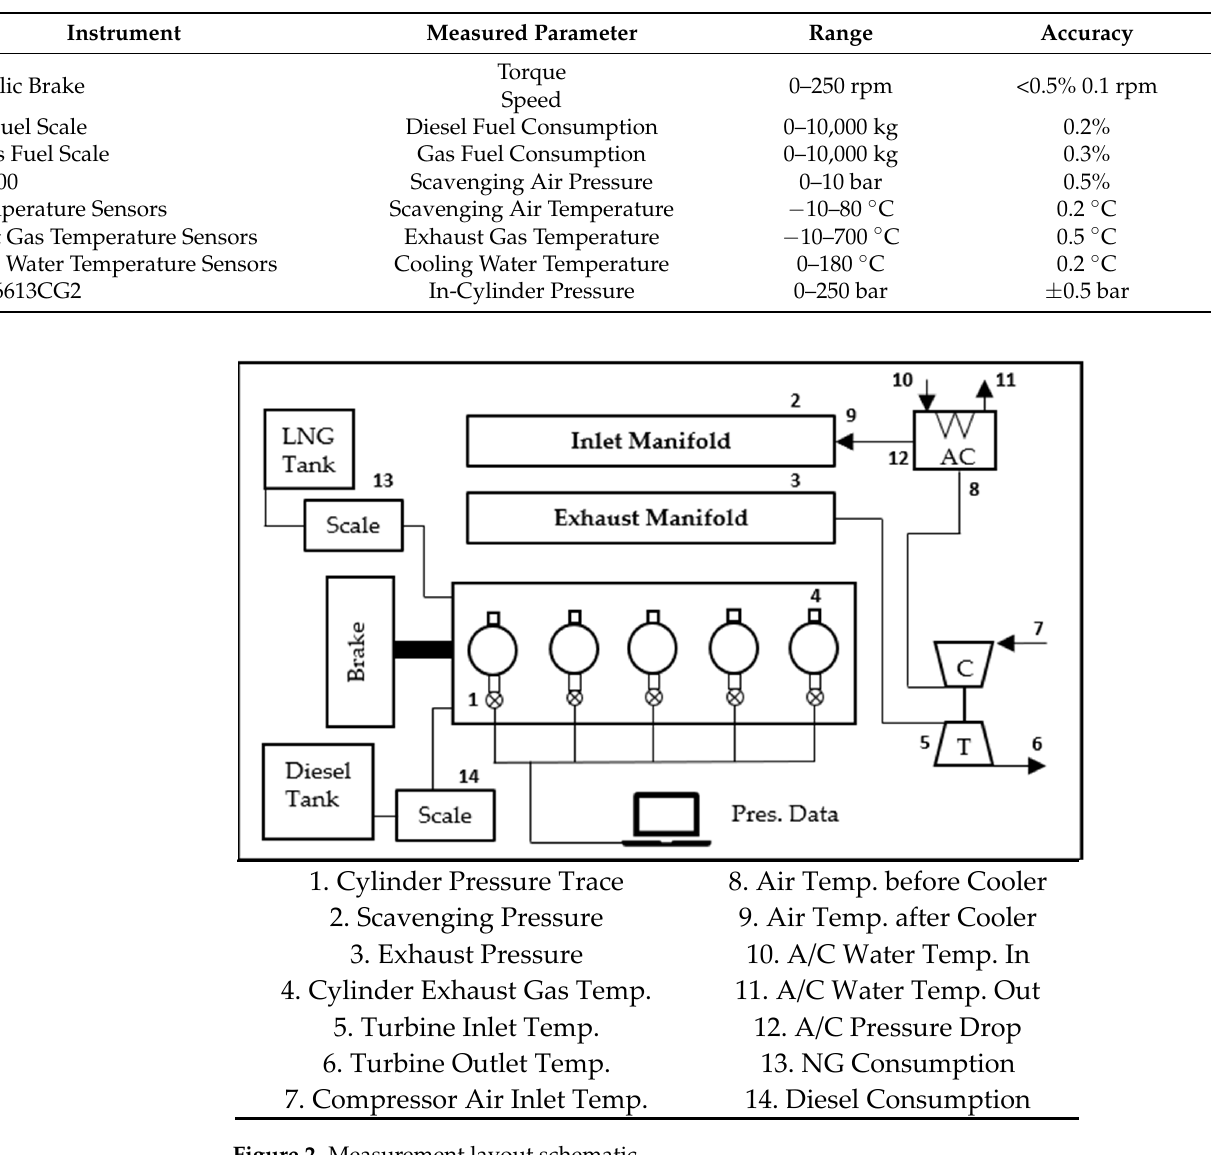
Figure 2. Measurement layout schematic. Table 1. Engine particulars tested.